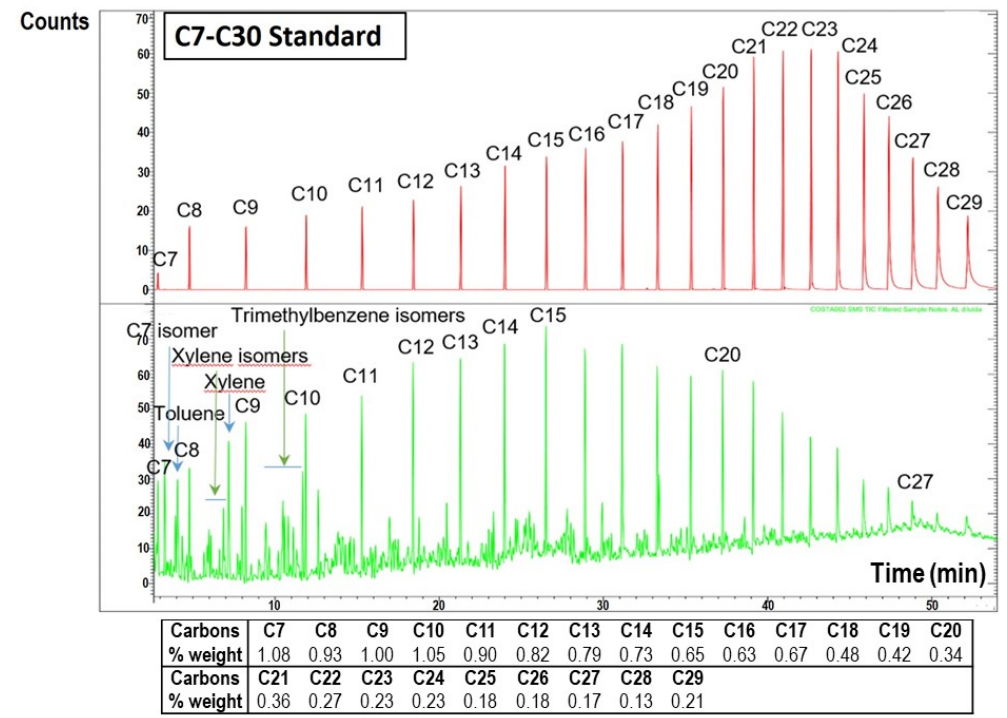
Figure 3. Arab Light characterization by GC–MS. The upper graph (red color spectrum) is the standard for C7–C30 aliphatic hydrocarbons and the lower graph is the result of Arab Light characterization (green color spectrum). C30 n ‐ alkane is not shown in the standard (not detected in Arab Light oil). The table below shows the composition in% weight of aliphatic hydrocarbons in this light crude oil, with a majority of C7–C12 compounds (individual abundance > 0.80%). The percentage of C7–C12 n ‐ alkanes over the global percentage of C7–C29 aliphatic alkanes distribution is 46.4%.